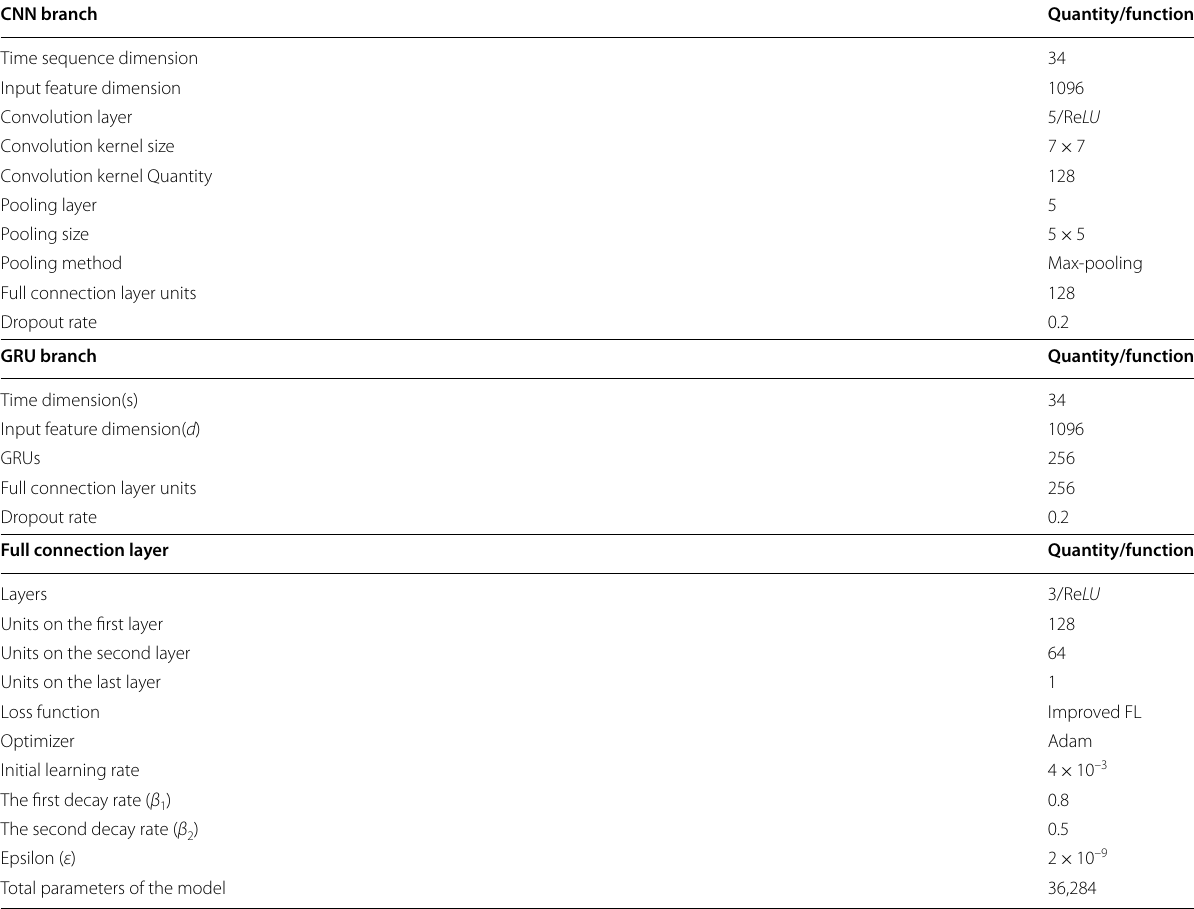
GRU on the IEEE 145-bus +